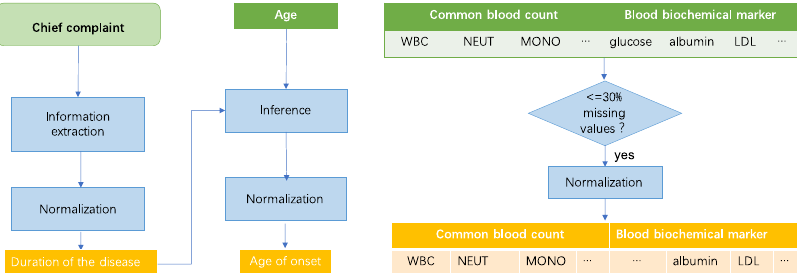
Fig. 3 Work fl ow of feature preparation. Two clinical features, duration of the disease and age of the disease onset, were extracted and calculated based on chief complaints; common blood biomarkers and blood biochemical markers with more than 30% missing values were removed, remaining 37 biomarkers normalized into z-scores.